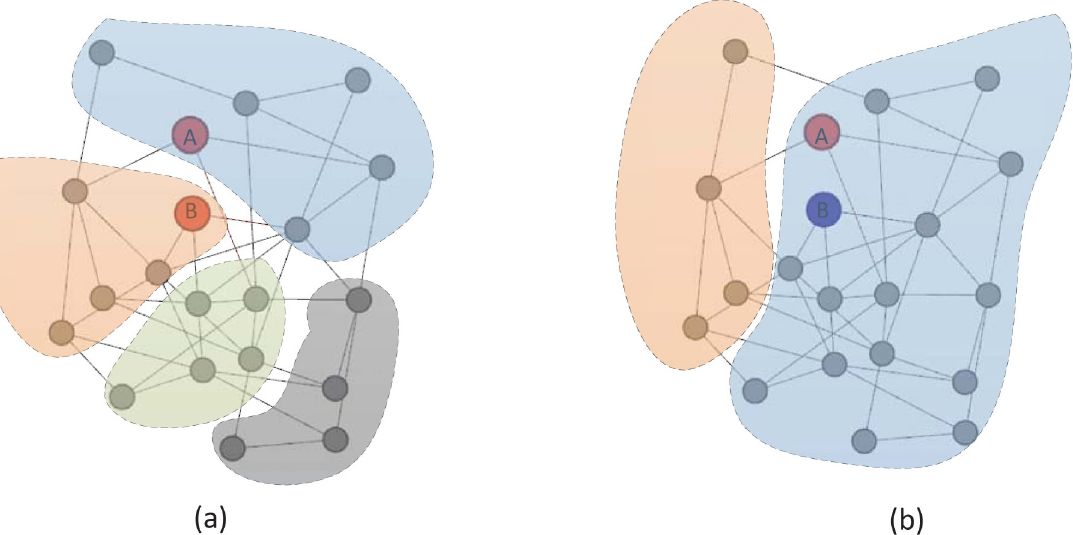
Fig 1. Classification process of SocioDim. The color of node A and node B represents their label. The shadow area represents the community, and different colors represent different communities. For soft clustering, the figure shows the results exceeding a